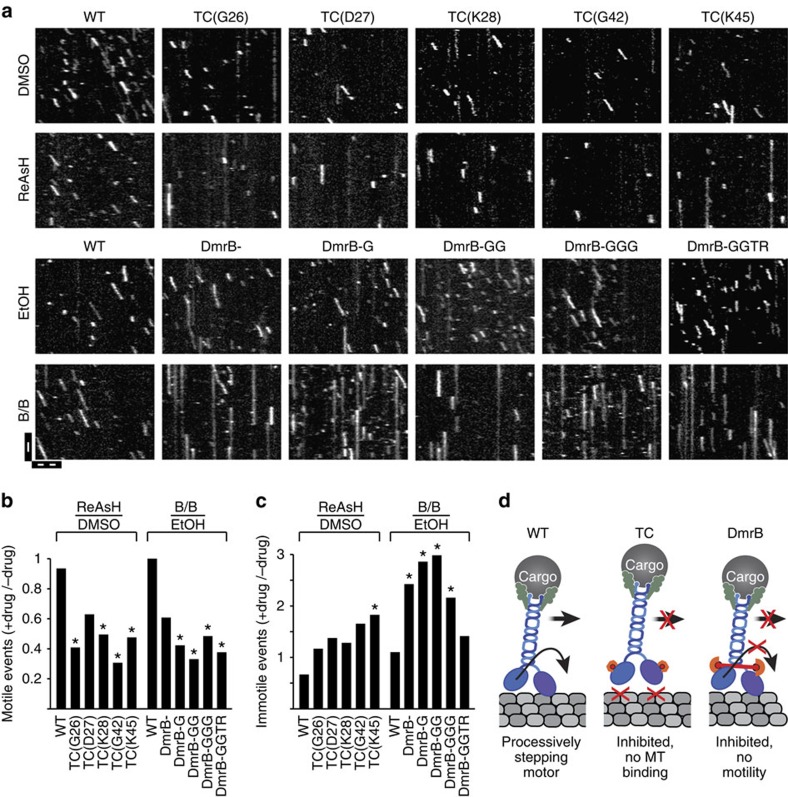
Inhibition of engineered kinesin-1 motors in single-molecule motility assays.(a–c) Lysates of COS7 cells expressing wild-type (WT), TC-tagged or DmrB-tagged RnKIF5C(1-559)-3xmCit motors were incubated for 30 min in the absence (EtOH, DMSO) or presence (20 μM ReAsH, 1.5 μM B/B) of the respective inhibitor, and the motility of single motors along taxol-stabilized microtubules was observed by TIRF microscopy. (a) Representative kymographs. The vertical axis is time (scale bar, 3 s) and the horizontal axis is distance along the microtubule (scale bar, 5 μm). (b,c) The mean number of (b) motile and (c) immotile events per micrometre of microtubule per min was determined from seven to nine time-lapse movies over three independent experiments. The data are presented as a ratio of the (number of events +drug)/(number of events–drug). *P<0.05; heteroscedastic, two-tailed t-test comparing event frequency in the absence and presence of drug. (d) Proposed inhibition mechanisms for engineered kinesin-1 motors. (left) WT kinesin-1 moves processively along the microtubule surface (grey). (Middle) Binding of ReAsH (red circle) to the TC-tagged motor domain interferes with motility by inhibiting microtubule binding. (Right) Binding of B/B homodimerizer (red dumbbell) to the DmrB-tagged motor domain crosslinks the motor domains, resulting in microtubule binding but no motility.